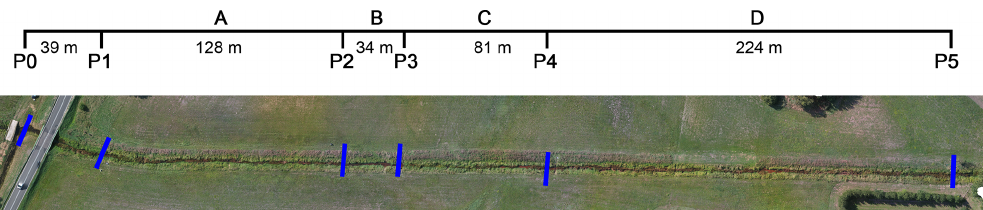
Figure 4. Aerial image captured in fully vegetated (Exp. 1) conditions and a scheme with marked cross-sections of the analysed reach of the Warszawicki Channel.